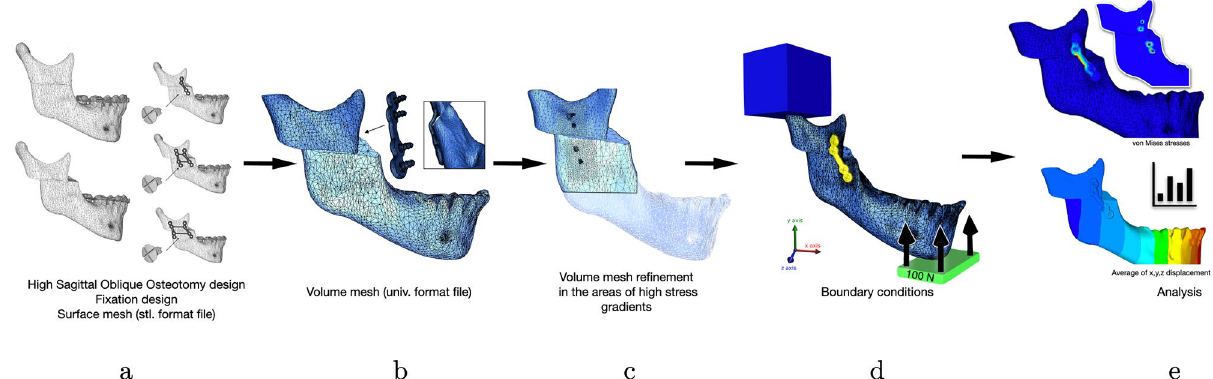
Figure 4. Methodology. ( a ) high sagittal oblique osteotomy and fixation design in surface mesh (stl. format file); ( b ) volume mesh generation (univ. format file); ( c ) volume mesh refinement in the areas of high stress gradients; ( d ) condyle boundary conditions and mandible loading; and ( e ) von Mises stresses and displacement analysis.